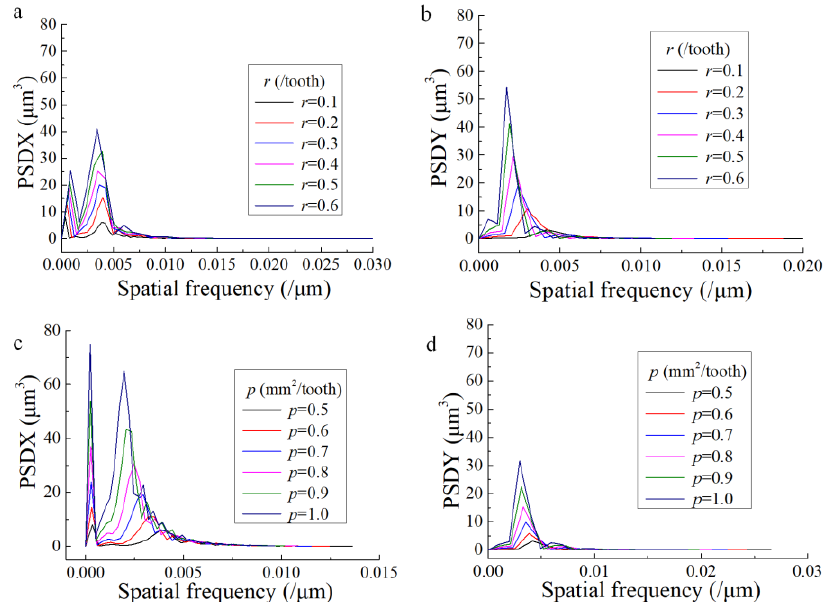
Figure 4. E ff ects of r and p on 1D power spectral density (PSD) along di ff erent directions ( a ) E ff ect of r Figure 4. Effects of r and p on 1D power spectral density (PSD) along different directions ( a ) Effect of on 1D PSD along step-over direction; ( b ) E ff ect of r on 1D PSD along feed direction; ( c ) E ff ect of p on 1D r on 1D PSD along step-over direction; ( b ) Effect of r on 1D PSD along feed direction; ( c ) Effect of p PSD along step-over direction; ( d ) E ff ect of p on 1D PSD along feed on 1D PSD along step-over direction; ( d ) Effect of p on 1D PSD along feed direction.